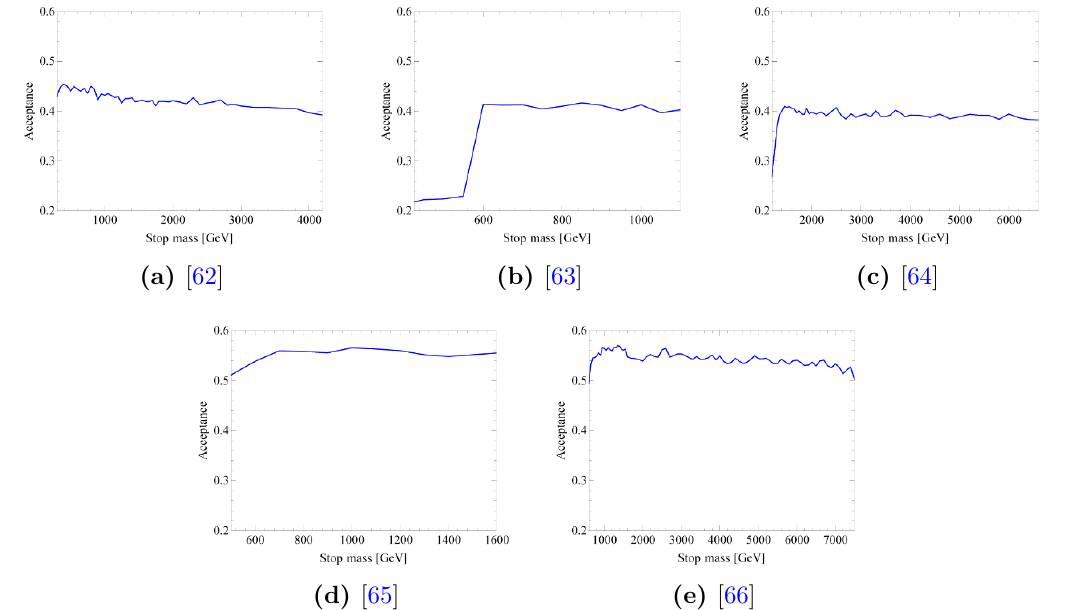
Figure 5. Acceptances for the dijet searches recasted in this analysis. Top row: ATLAS searches. Bottom row: CMS